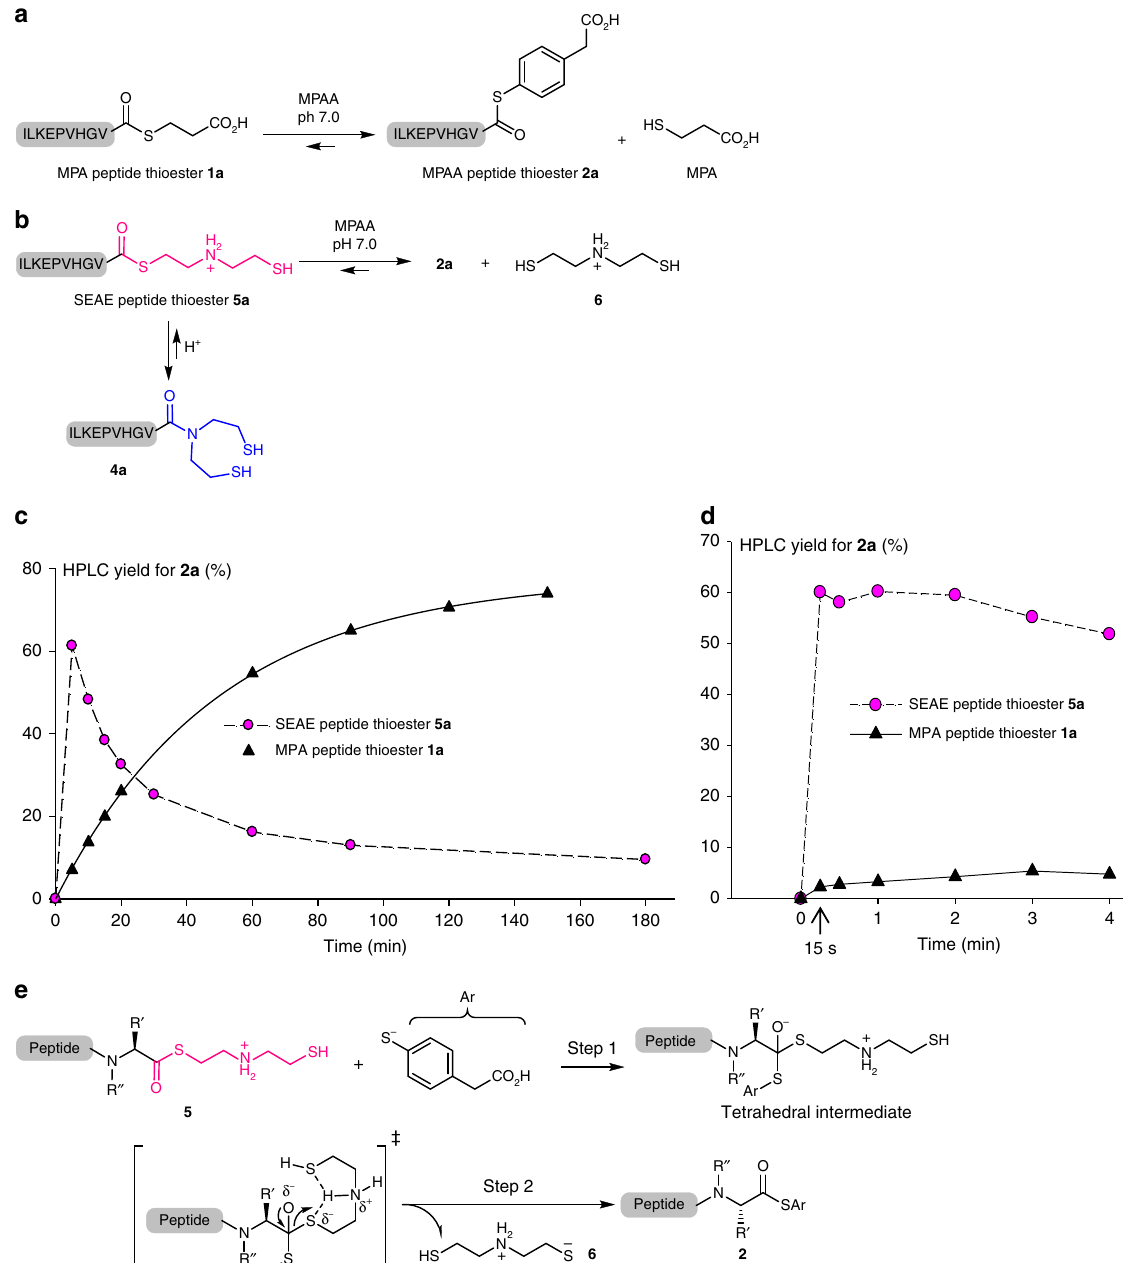
Fig. 2 Evidence for the enhanced reactivity of SEAE peptide thioesters. a Principle of the thiol-thioester exchange between MPA peptide thioester 1a and MPAA. b Principle of the thiol-thioester exchange between SEAE peptide thioester 5a and MPAA. c Evidence for the high reactivity of model SEAE peptide 5a (circles fi lled with magenta) featuring a C-terminal dif fi cult amino acid (valine) in comparison with the classical MPA peptide thioester analog 1a ( fi lled triangles). The peptides were reacted in 0.2 M sodium phosphate buffer (pH 7.0) containing 50 mM TCEP and 400 mM MPAA at 37 °C. The exchange reaction was monitored by HPLC (UV detection at 215 nm). d Same reactions as in c under the optimal micro fl uidic conditions described in Fig. 4 ( 1a : black triangles, 5a : magenta circles). e The high reactivity of SEAE peptide thioesters is potentially a consequence of an intramolecular acid-catalysis that facilitates departure of thiol 6 from the tetrahedral intermediate (step 2). This step is rate-limiting for simple alkylthiols such as MPA. R ’ and R ” correspond to the amino acid side-chain (see Fig.